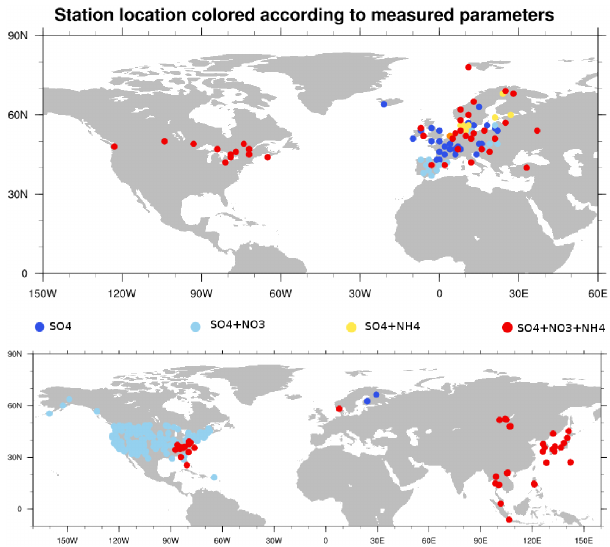
Figure 1. Maps with the location of the stations measuring in 2005 used to evaluate the model. Colours represent the measured param- eters at the station. The upper panel represents daily observation stations, while the bottom panel represents weekly observation sta-